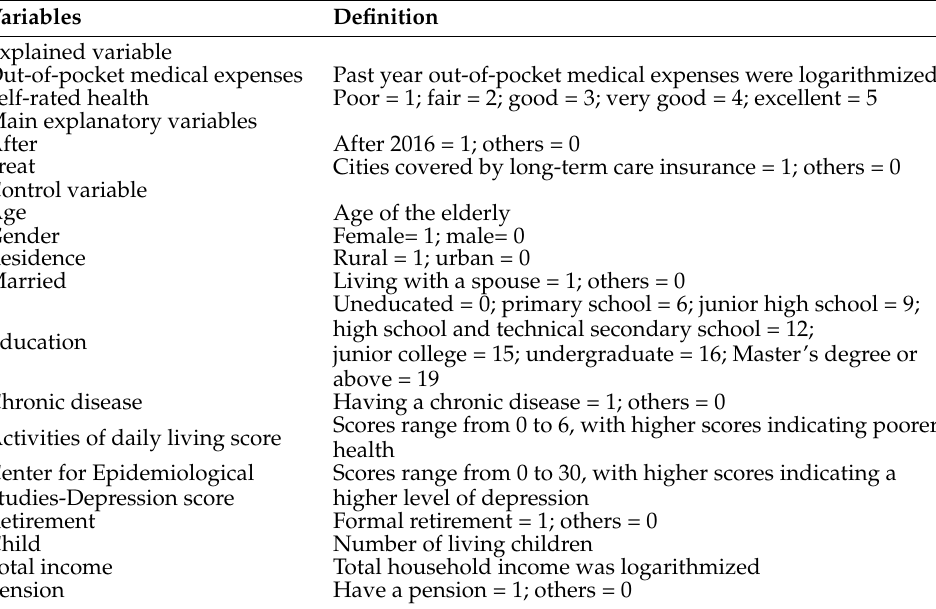
Table 2. Definitions of variables.